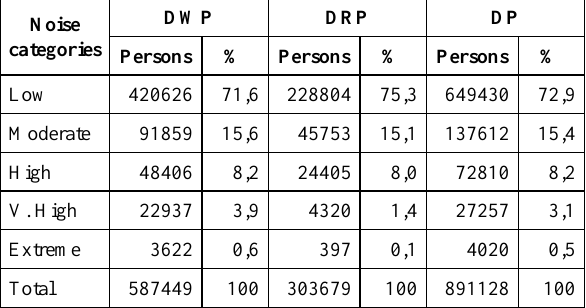
Table 6. Exposure of daytime worker (DWP), residential (DRP), and daytime total (DP) to aircraft noise in Lisbon in